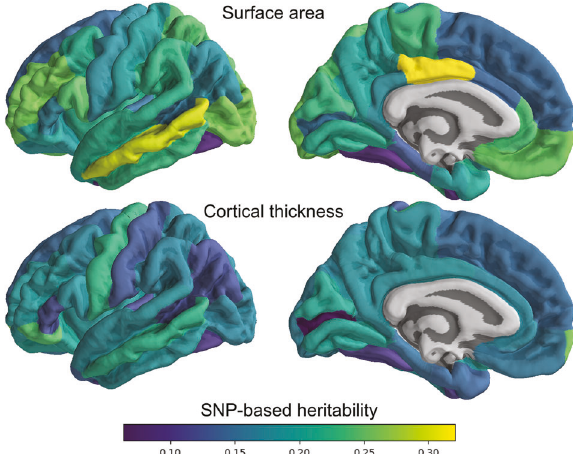
Fig. 1 Regional SNP-based heritability across the cortex, with the lateral (left) and medial (right) views for surface area at the top and cortical thickness at the bottom row. The estimates are calculated through LD score regression [132], applied to MRI data from 33,735 White European individuals as described previously [115], and parcellated according to the widely-used Desikan Killiany atlas [133]. As indicated through the colour-coding, heritability ranges from below 0.10 to above 0.30, with the regional estimates for surface area showing a wider spread than cortical